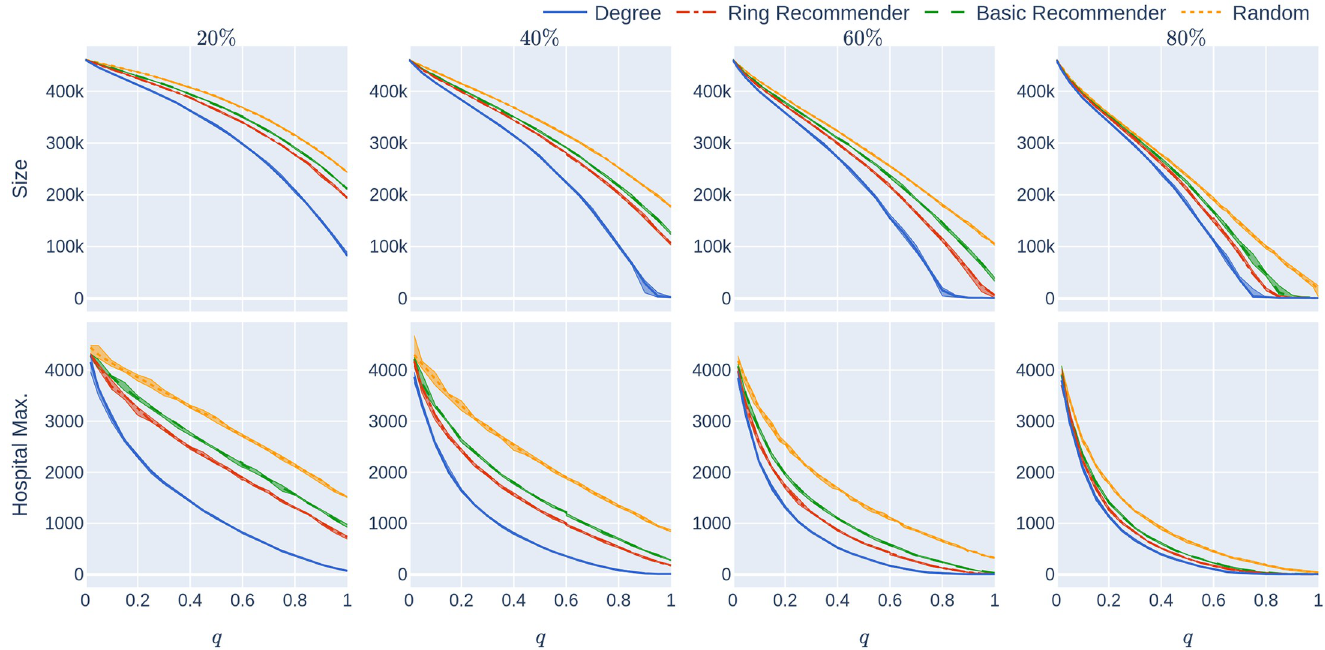
Fig 10. Experiment 2 on a less geometric network with not too many super-spreaders: Influence of the quarantine strictness q for various uptake percentages p % and the four uptake scenarios at infection rate β = 0.05. The underlying network is a 500,000-node GIRG with τ = 3.3 (fewer super-spreaders) and α = 1.3 (less geometric). Each column represents an uptake percentage. The x -axis shows the quarantine strictness q varying from 0 to 1 at step size 0.05. Simulations are done for the 21 values of q corresponding to these steps. There is an additional simulation point at 0.02 (in order to avoid division by 0 in the computation for HMax and still have a point close to 0). The y -axis shows the corresponding value of the KPI. The curves in each figure correspond to the different uptake scenarios, as labelled. For each parameter value, the plotted result is the median over 5 runs. The shaded region around the plot covers the results of all 5 simulations. The epidemic is started by infecting 100 individuals, chosen uniformly at random. Simulation is halted when there are no more exposed or infected vertices.